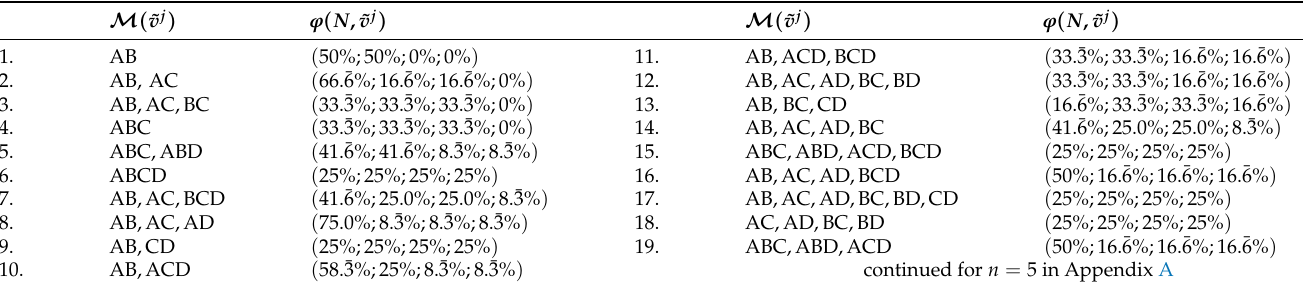
Table 4. Shapley allocations for all dichotomous damage scenarios with n ≤ 4